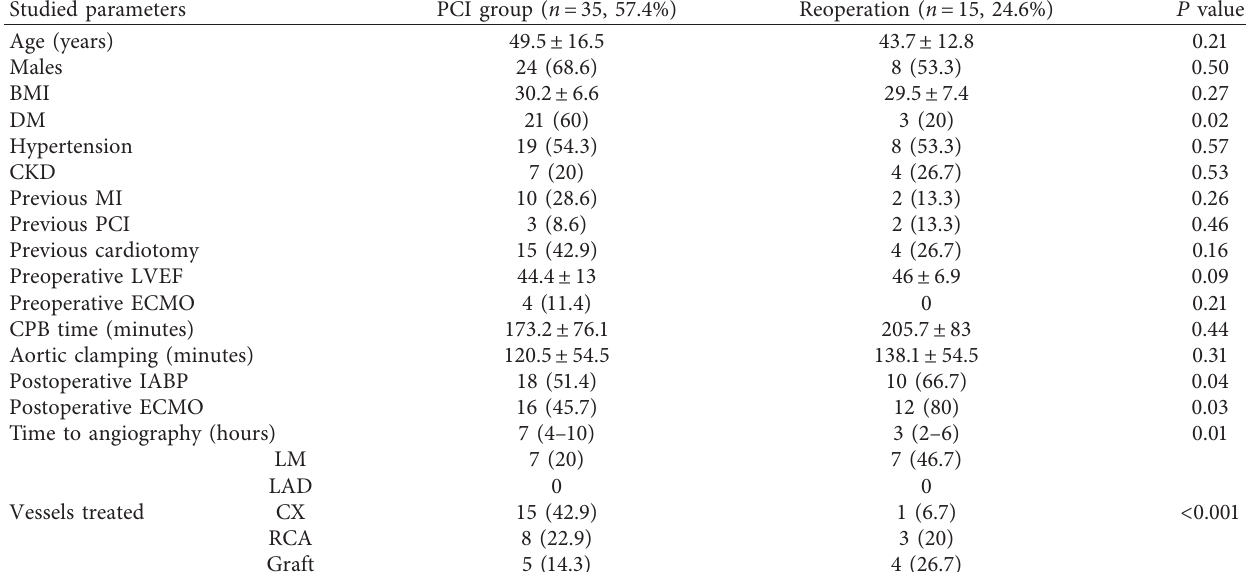
Table 4: Baseline characteristics of the PCI and reoperation groups.